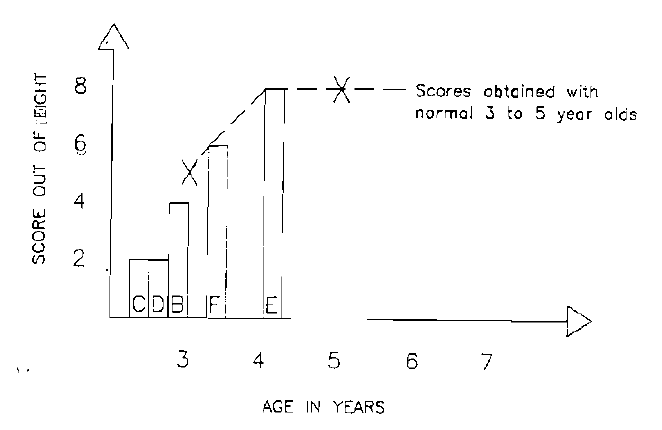
Figure 3. Comparison of scores for sentence analy- sis with normal 3 to 5 year olds.